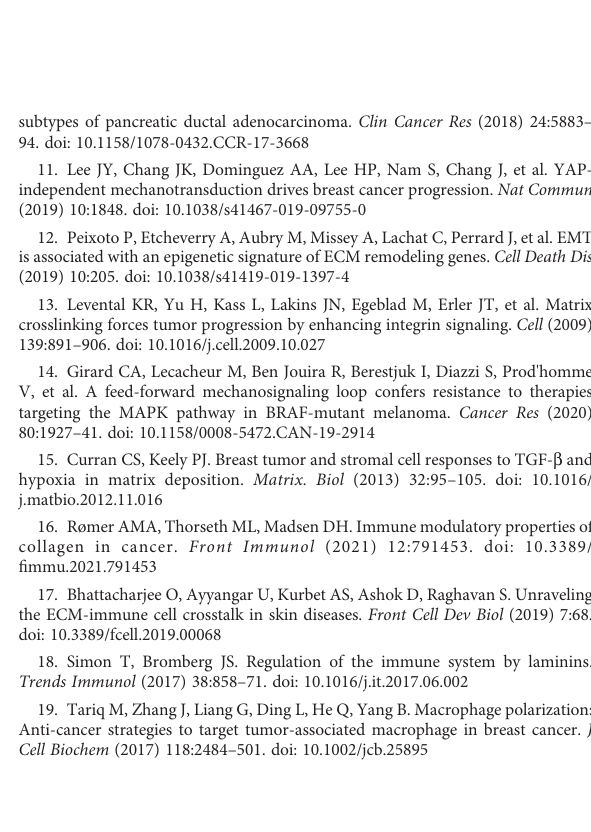
SUPPLEMENTARY FIGURE 1 Overview of expression levels, mutation and CNV of ECM-associated genes in breast cancer. (A) . Heatmap showing the differences in expression levels of ECM-associated genes between breast cancer and normal mammary gland tissues. (B) . Volcano map showing the distribution of differentially expressed ECM-associated genes between breast cancer and normal mammary gland tissues. (C) . Waterfall plot showing the mutation pro fi les of ECM-associated genes in breast cancer. (D) . The CNV pro fi les of ECM-associated genes in breast cancer. CNV, copy number variation. SUPPLEMENTARY FIGURE 2 Identi fi cation of ECM-clusters by consensus clustering. (A) . The CDF curves obtained by consensus clustering based on ECM-associated genes. (B) . The function delta area under CDF curves. SUPPLEMENTARY FIGURE 3 The LASSO Cox regression coef fi cient pro fi les for establishing the ECM- associated prognostic model. Abbreviations: LASSO, least absolute shrinkage and selection operator. SUPPLEMENTARY FIGURE 4 Mutation pro fi les, stemness index correlation and drug sensitivity prediction of breast cancer patients in different risk groups. (A-B) . The mutation pro fi les of breast cancer patients in high-risk (A) and low-risk (B) groups. C. Correlation analysis between risk scores and stemness index in breast cancer patients. (D-G) . Prediction of drug sensitivity of breast cancer patients to antitumor agents – Bicalutamide (D) , CMK (E) , Ge fi tinib (F) and Gemcitabine (G) - in different risk groups. SUPPLEMENTARY TABLE 1 The 328 ECM-associated genes provided by gene ontology terms. SUPPLEMENTARY TABLE 2 The information of genes sets for 23 immune cells for ssGSEA